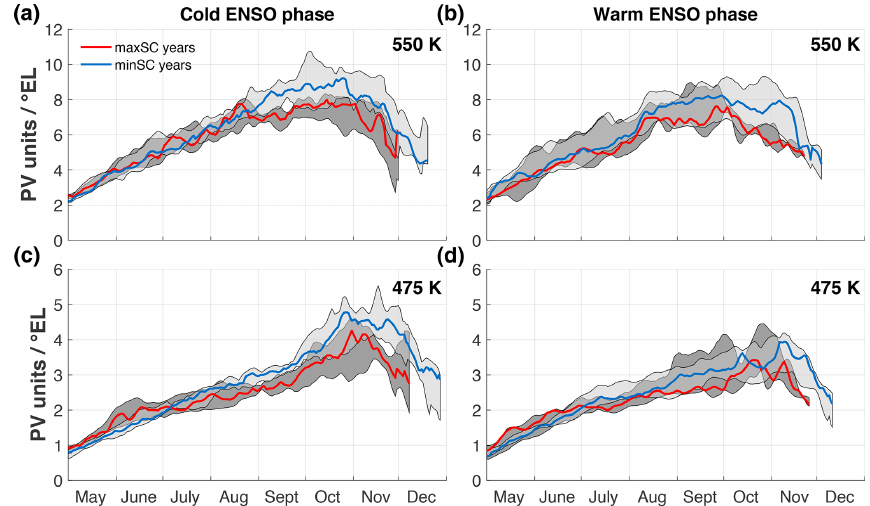
Figure 6. Composites of the seasonal evolution of vortex edge intensity according to SC and ENSO for the period 1979–2020, from (a) to (d) : 550 and 475K. Panels (a) and (c) represent cENSO phases and panels (b) and (d) represent wENSO phases (see Sect. 2.2). Red curves represent median values for maxSC years and blue curves for minSC years. Dark gray areas indicate values between the 20th and 80th percentiles for maxSC years and light gray areas for minSC